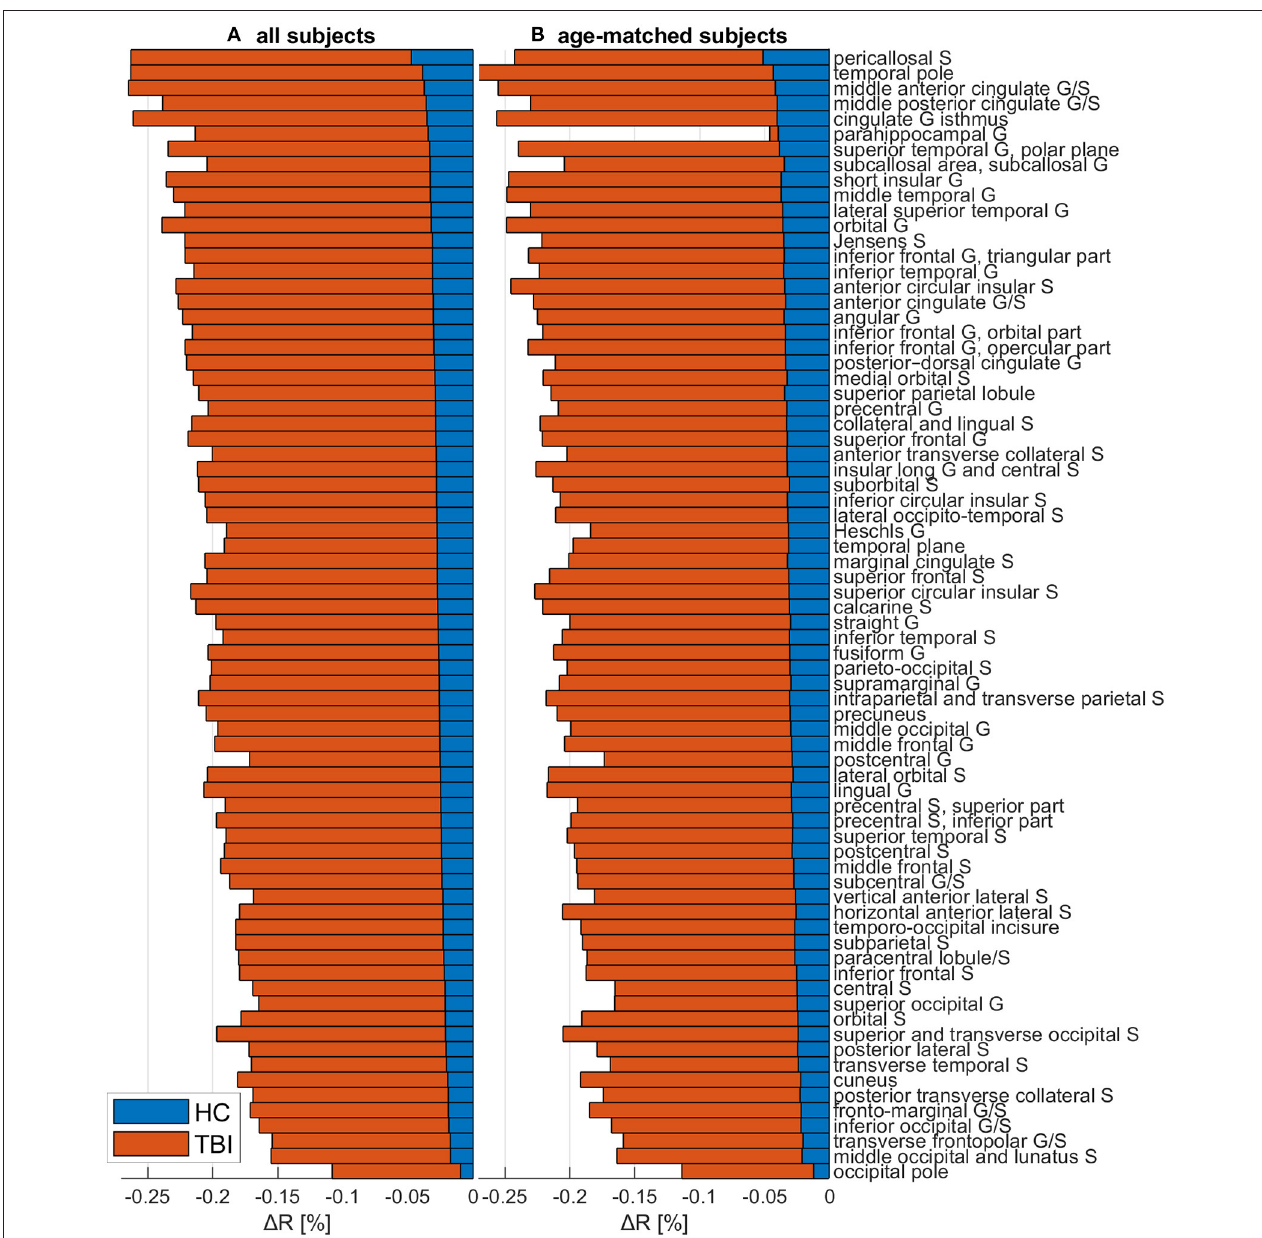
FIGURE 6 | The change 1 R in the myelination ratio R for HCs (blue) and mTBI participants (orange), across both (A) the full cohort and (B) a sub-cohort containing only mTBI and HC subjects whose age ranges overlap. 1 R was calculated as 1 R = ( R f − R b )/ R b , where R b is the R value at acute baseline and R f is the R value at chronic follow-up. 1 R values were averaged across subjects and then across all cortical vertices within each region. Values are ordered in the ascending order of the full HC cohort’s 1 R values. Abbreviations: G, gyrus; HC, healthy control; mTBI, mild traumatic brain injury; S, sulcus.